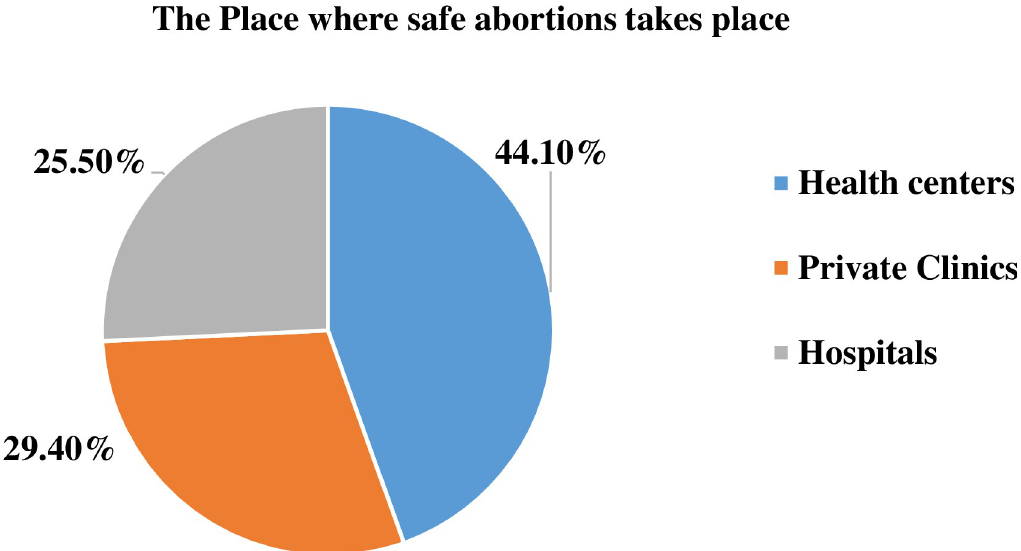
Fig 1. The list of health facilities visited by insecurely housed women for safe abortion service in southwest Ethiopia, 2021.